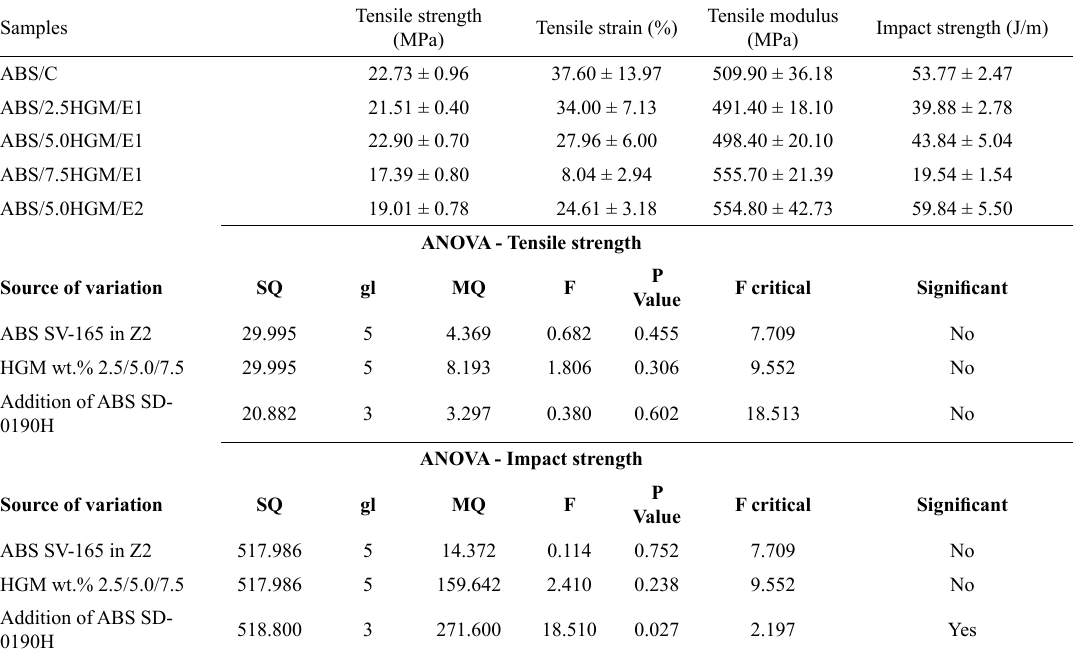
Table 3. Mechanical properties of the composites as a function of HGM content with statistical analysis of the samples studied. Samples